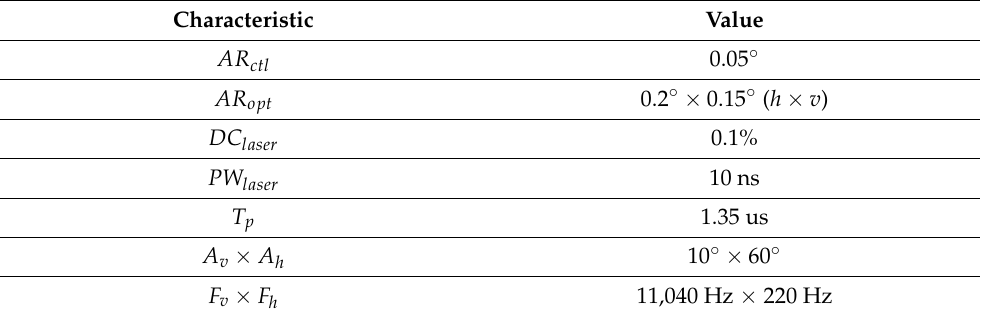
Table 2. Influence factors on angular